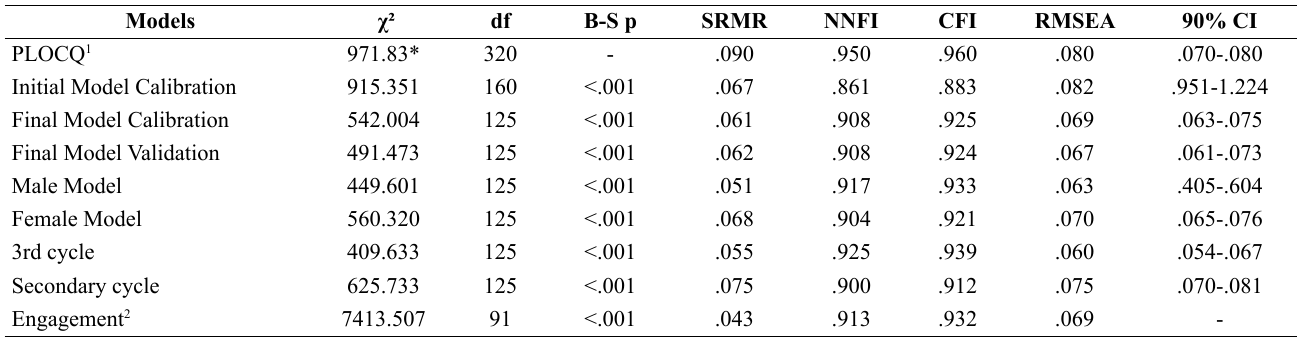
Table 2 Fit indices of the measurement models of PLOCQp (including existing versions)